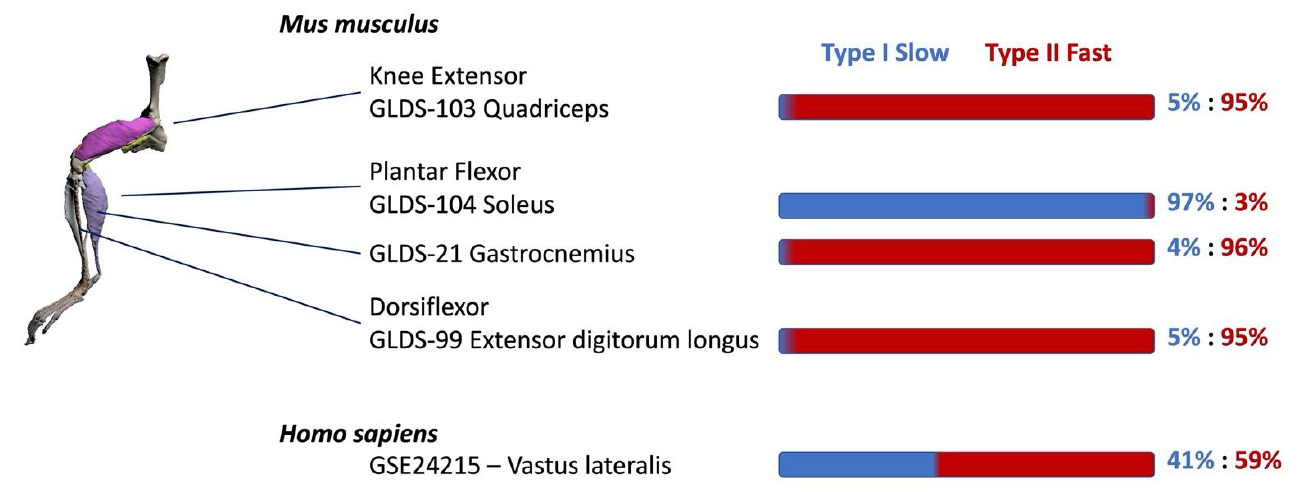
Figure 1. Anatomical positions of the various mouse and human muscles used in this study, grouped by function. The right panel shows the percentage of slow and fast twitch fibers for each muscle.